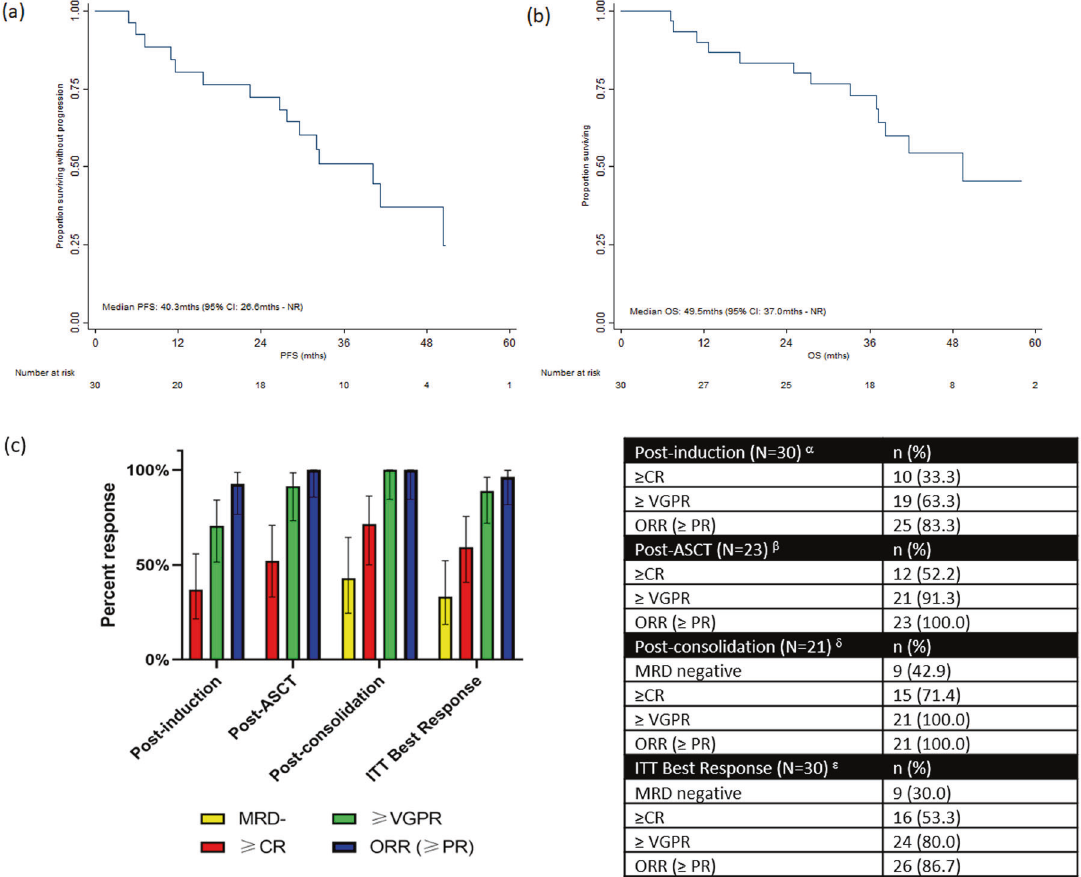
Fig. 1 Survival and Response Rates. Kaplan – Meier plot of PFS ( a ), OS ( b ), and response rates ( c ). α Best responses were attained in induction among patients who had received at least one dose of the study drug. β Responses among patients who had completed induction and autologous stem cell transplant. δ Responses among patients who had completed induction, autologous stem cell transplant, and consolidation. ε Best response attained during trial among all